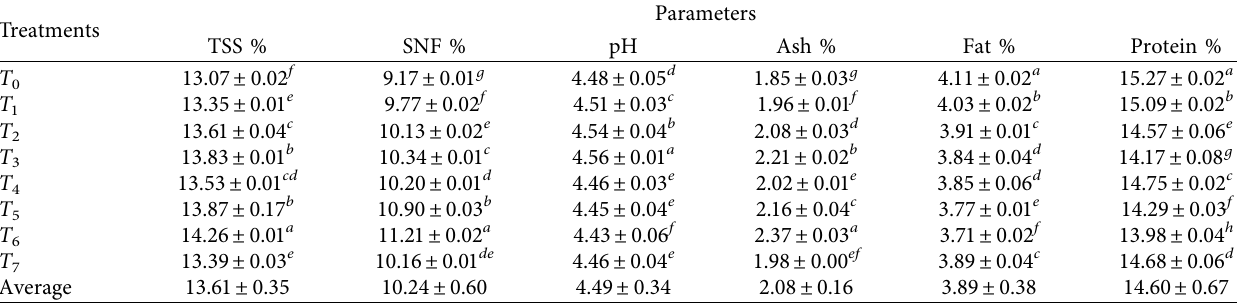
Table 5: Effect of adding apple pomace powder and pomegranate peel powder on the rheological profile of yogurt. Values in mean column are given in (mean ± SD).